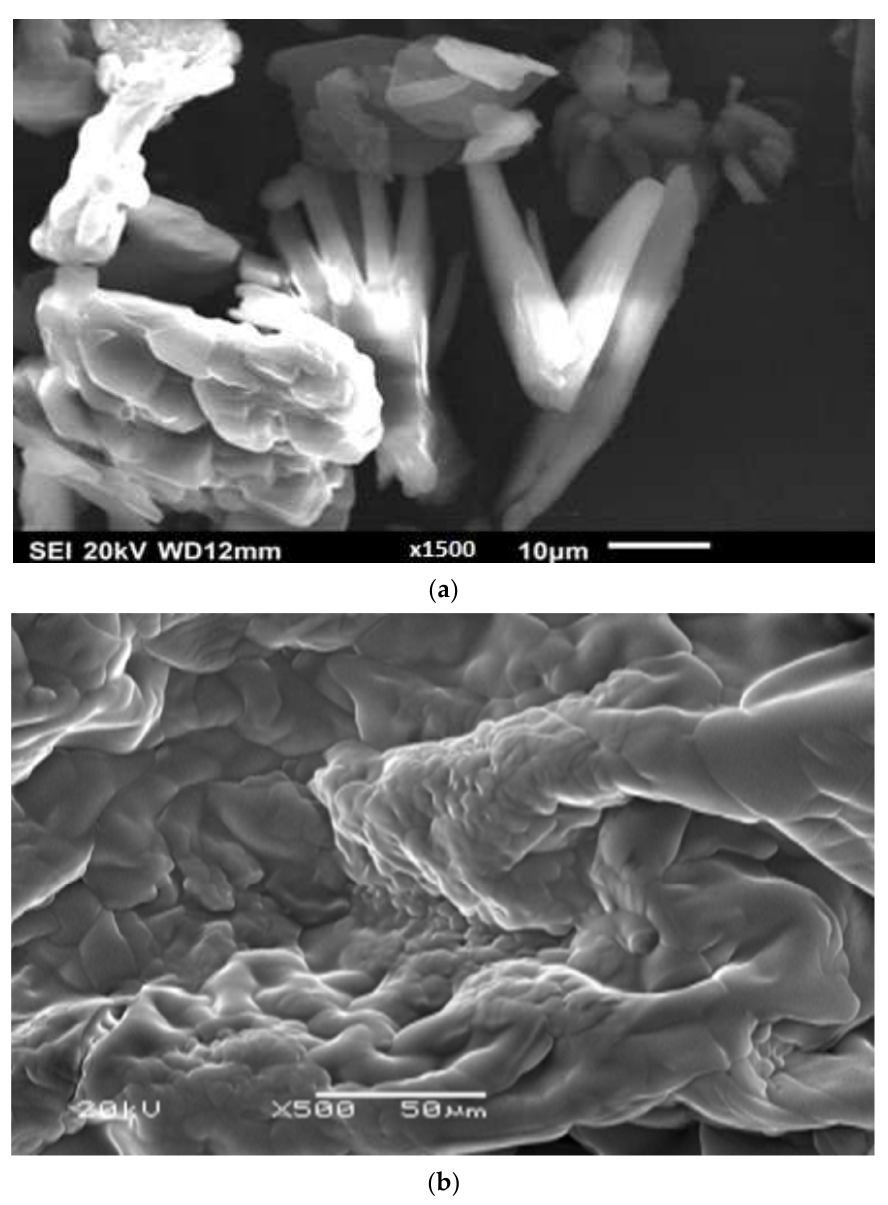
Figure 2. SEM micrograph of ( a ) PBOCOSA and its amided copolymer ( b ) PBOCODSA.